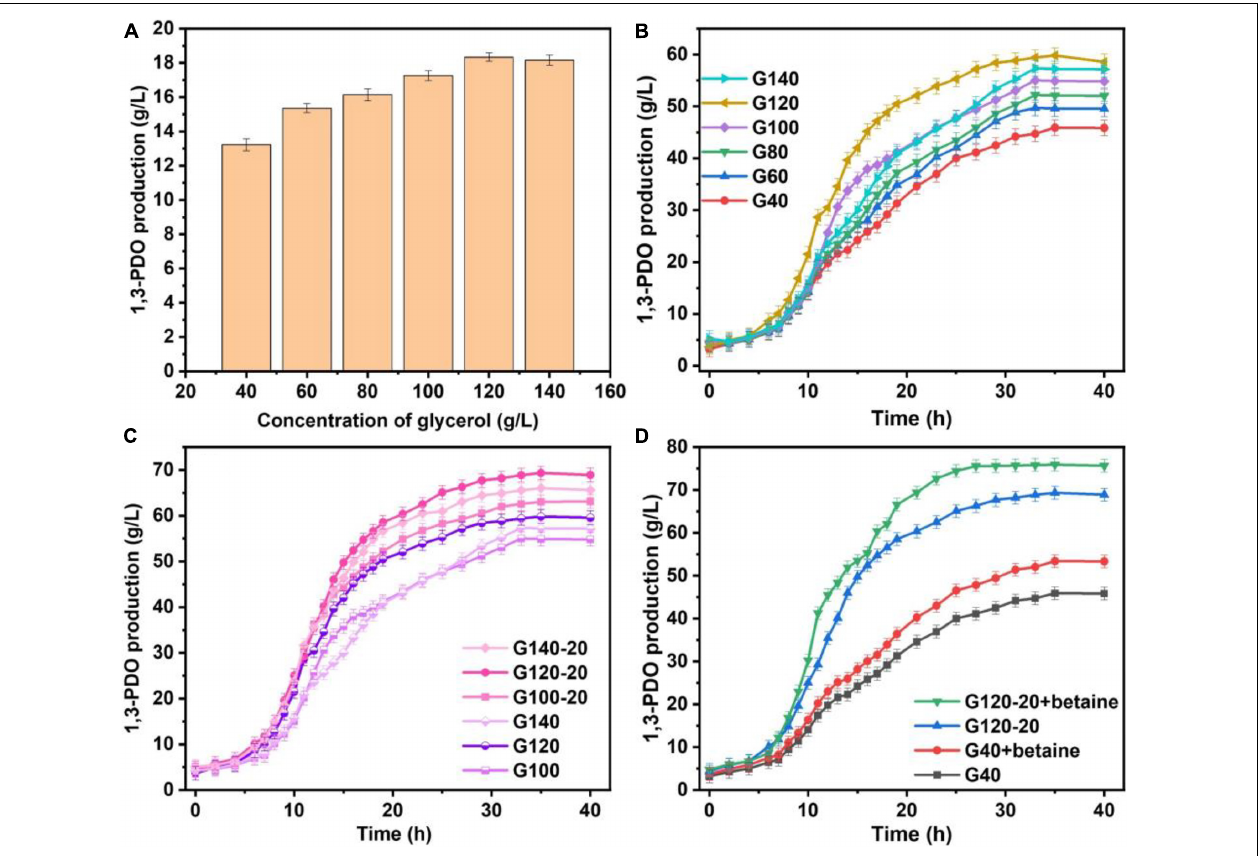
FIGURE 1 | (A) Compa re the production of 1,3-PDO in the 250-mL shaker with glycerine domestication concentration at 40, 60, 80, 100, 120, and 140 g/L. (B) The comparison of the yield of 1,3-PDO in the 7.5-L fermentation tank with glycerine domestication concentration at 40, 60, 80, 100, 120, and 140 g/L. (C) The production 1,3-PDO in the 7.5-L fermentation tank with glycerine domestication concentration at 100, 100–20, 120, 120–20, 140, and 140–20 g/L. (D) The capacity of 1,3-PDO in the 7.5-L fermentation tank with glycerine domestication concentration at 40 g/L, 40 g/L +betaine, 120–20 and 120–20 g/L